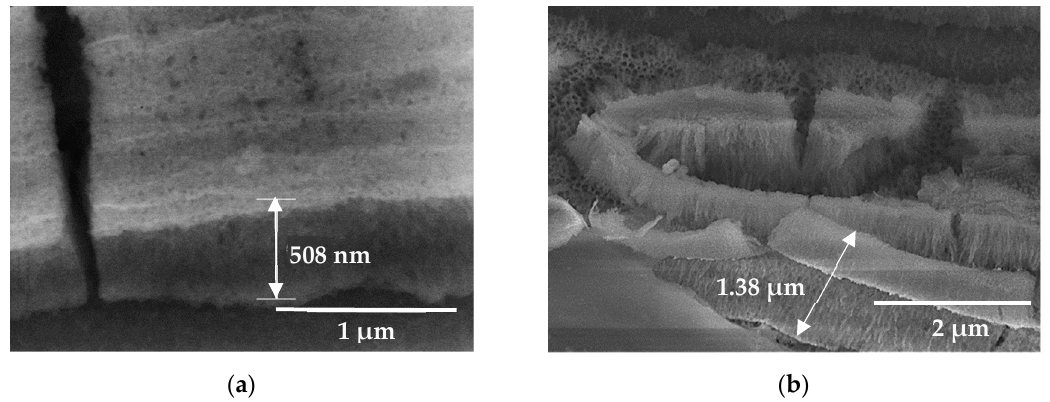
Figure 4. SEM images of anodic layer thickness grown in ethylene glycol-NH 4 F-H 2 O electrolyte for ( a ) 15 min and ( b ) 60 min at 0 rpm.